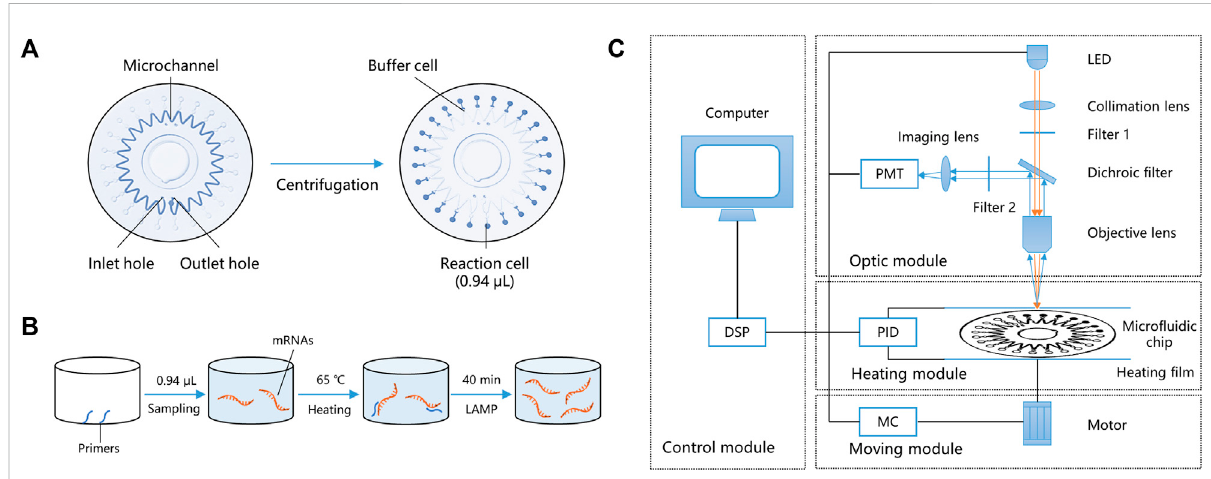
FIGURE 2 Working principle of the miniaturized micro fl uidic chip system. (A) Structure and liquid distribution of the micro fl uidic chip. (B) Reaction principlesofLAMPinabioreactorcell. (C) Schematicoftheminiaturizedreal-time fl uorescencedetector.DSP:Digitalsignalprocessor;PMT:Photo- multiplier; LED: Light-emitting diode; PID: Proportional integral derivative; and MC: Moving